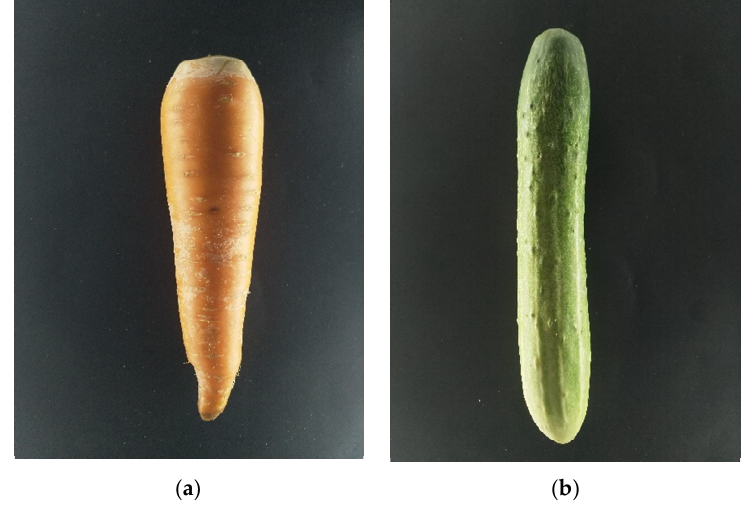
Figure 19. Top view images: ( a ) carrot, ( b ) cucumber.